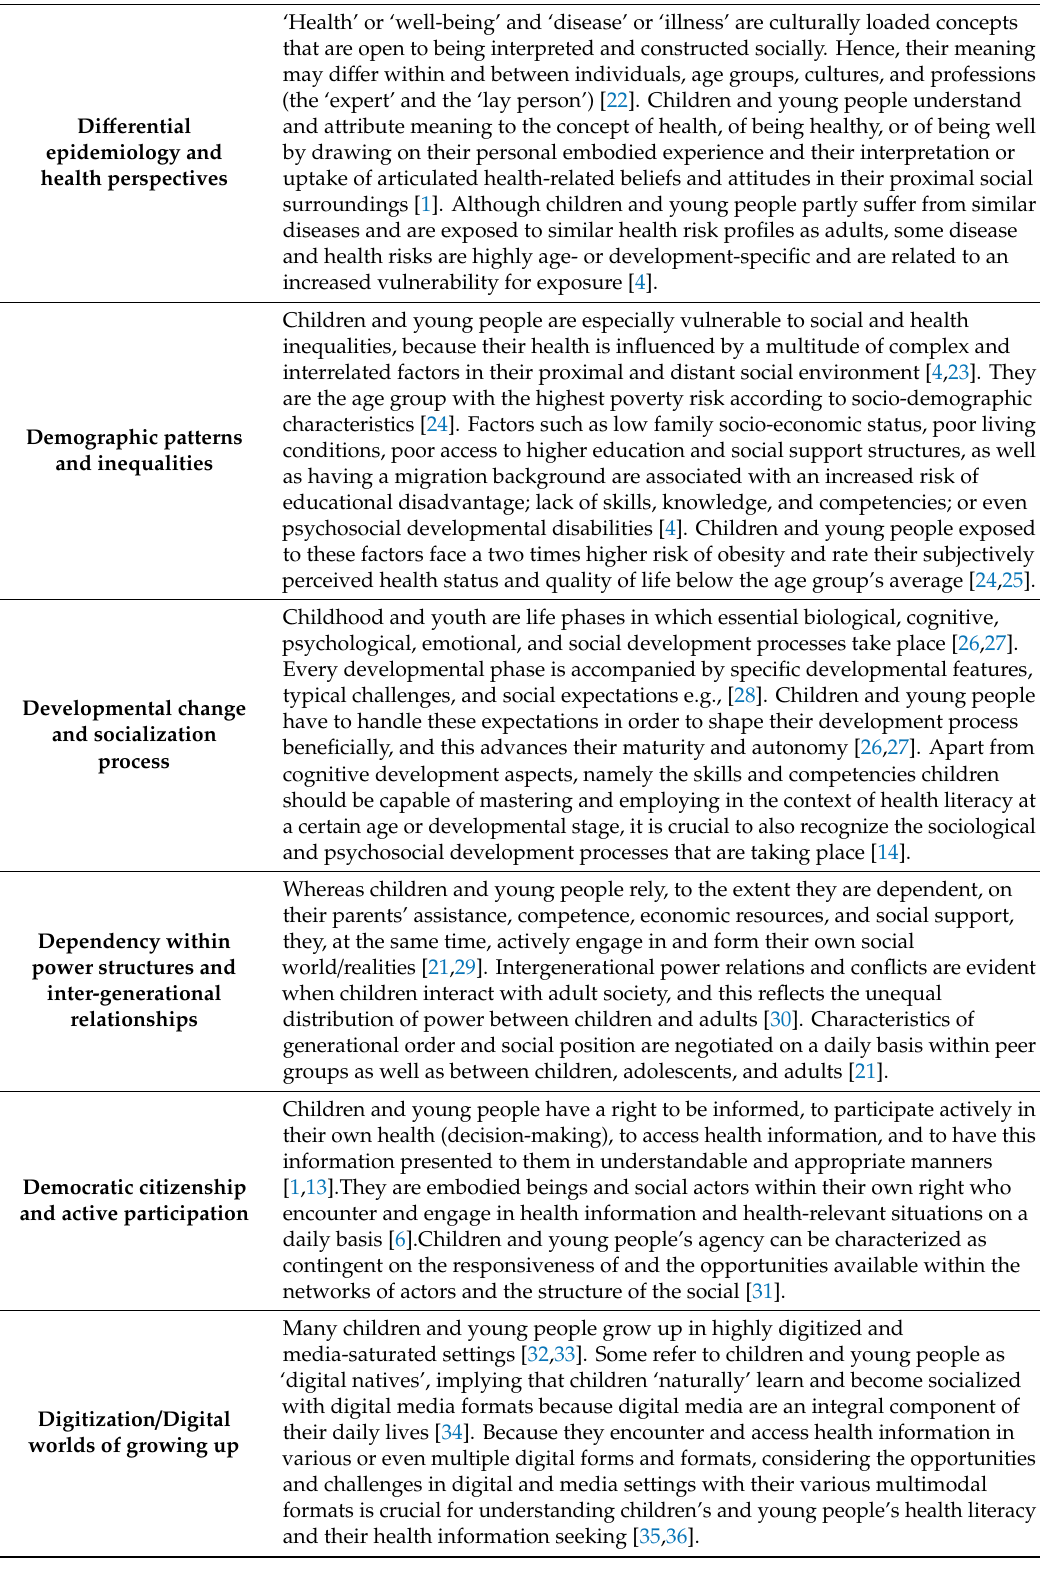
Table 2. Description of dimensions of the health literacy 6-D model (for an earlier version, see [13,18]). ‘6